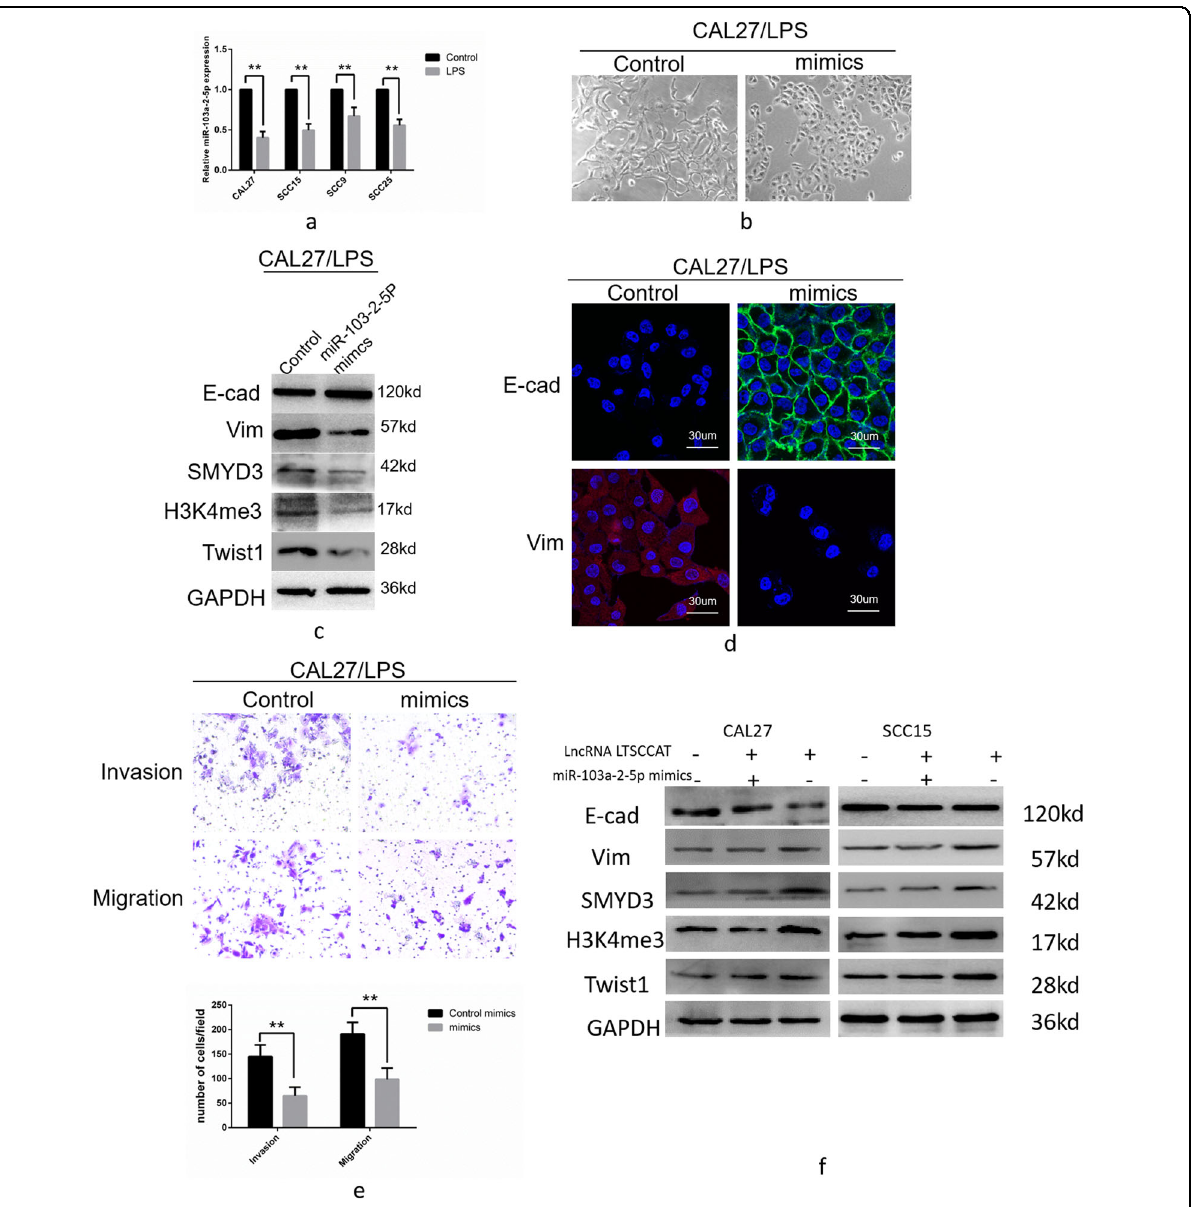
Fig. 6 Overexpression of miR-103a-2-5p in CAL27/LPS cells inhibited the invasion and migration of tongue squamous cell carcinoma cells. a The expression of miR-103a-2-5p was reduced in the P.g-LPS-induced TSCC cell lines CAL27, SCC15, SCC9, and SCC25. Error bars represent the mean±S.D. from three independent experiments. (** P < 0.01). b After transfection of miR-103a-2-5p mimics in CAL27/LPS, the cell morphology transitioned from interstitial to epithelial (×200). c Western blot analysis showed that after transfection of miR-103a-2-5p mimics in CAL27/LPS, E- cadherin increased and vimentin and Twist1 decreased. d Immuno fl uorescence demonstrated an increase in E-cadherin and a decrease in vimentin after transfection of miR-103a-2-5p mimics in CAL27/LPS cells. e Transwell invasion and migration experiments con fi rmed that invasion and migration of tongue squamous cell carcinoma were reduced after transfection of miR-103a-2-5p mimics in CAL27/LPS cells. Error bars represent the mean±S.D. from three independent experiments. (** P < 0.01). f Western blotting revealed that transfection of miR-103a-2-5p in CAL27 and SCC15 cells overexpressing LTSCCAT rescued the expression of SMYD3, H3K4me3, and EMT-related